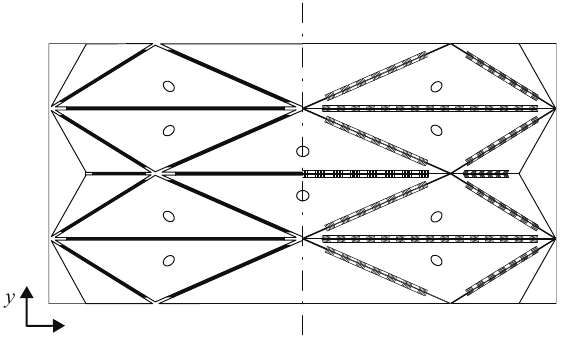
Figure 12. Strip model ( left ) and spring model ( right ) geometry representation within ABAQUS. Partitioned circular surfaces for applying load are also shown. In the spring model presented here, each MTSJ tab is represented by groups containing seven sets made of three different spring types, uniformly distributed along the tab